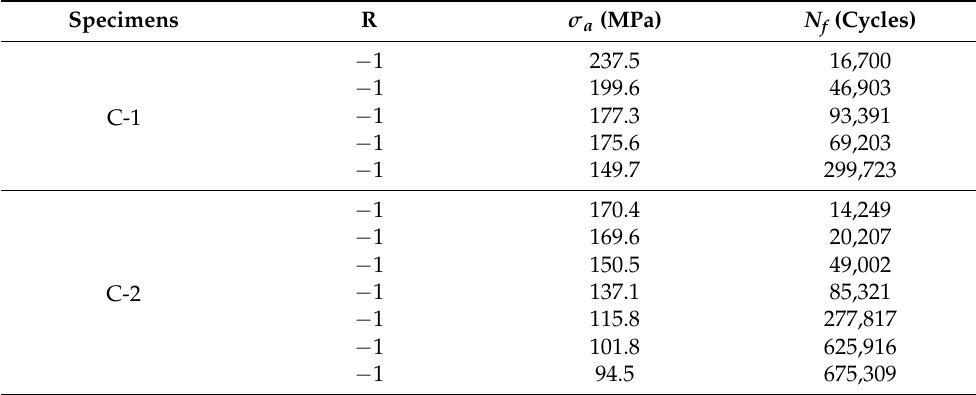
Table 5. Fatigue test data of EN3B alloy under loadings, data from